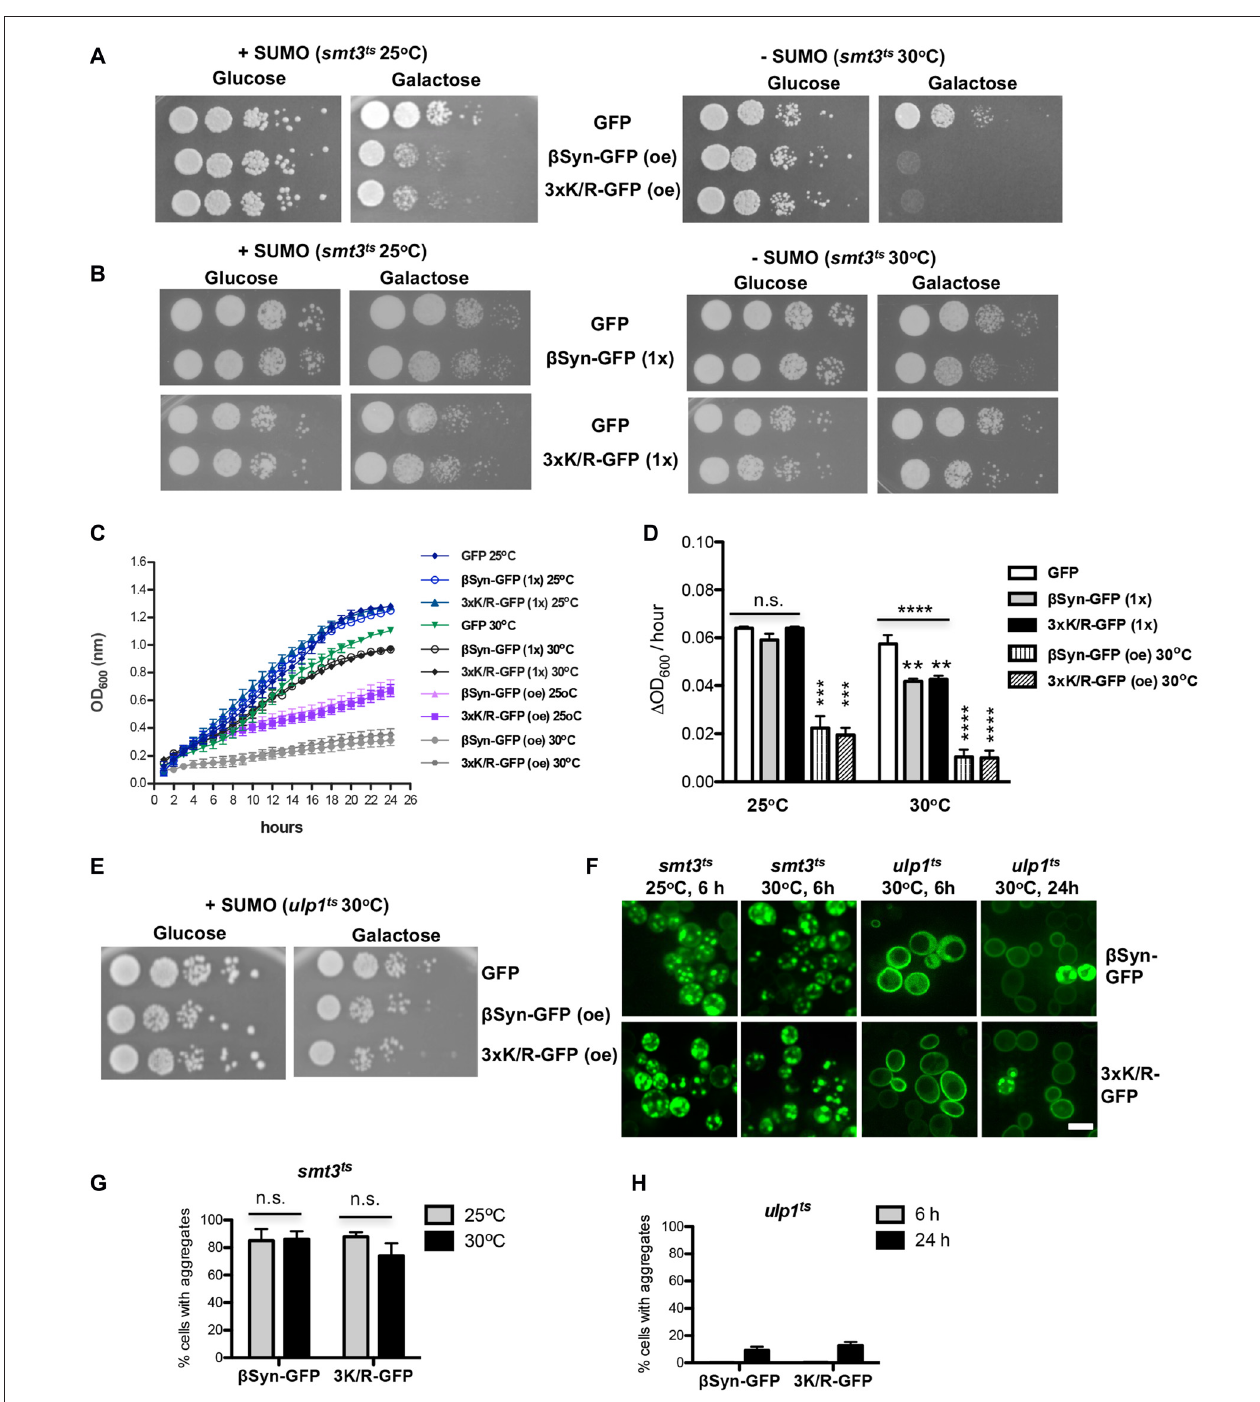
FIGURE 4 | Impairment of sumoylation increases β Syn-GFP induced toxicity. (A) Spotting assay of smt 3 ts mutant strain expressing β Syn-GFP and 3xK/R-GFP at permissive (25 ◦ C; +SUMO) or restrictive temperature (30 ◦ C; − SUMO). GAL1 -driven synucleins are expressed from 2 µ plasmid (oe-overexpression). GFP, expressed from the same promoter, is used as a control. Yeast cells were spotted in 10-fold dilutions on selection plates containing glucose ( GAL1 promoter “OFF”) or galactose ( GAL1 promoter “ON”). (B) Spotting assay of smt 3 ts mutant strain expressing one copy (1x) of β Syn-GFP or 3xK/R-GFP. Yeast cells, expressing GFP were used as a control. (C) Growth analysis of yeast cells from (A,B) in galactose-containing medium for 24 h at the indicated temperatures. (D) Growth rate of yeast cells in logarithmic phase. Significance of differences was calculated with One-way Anova test or t -test, relative to the GFP control ( ∗∗ p < 0.01; ∗∗∗ p < 0.001; ∗∗∗∗ p < 0.0001; n = 4). (E) Spotting assay of ulp1 ts mutant strain expressing β Syn-GFP and 3xK/R-GFP from 2 µ plasmid at 30 ◦ C. (F) Live-cell fluorescence